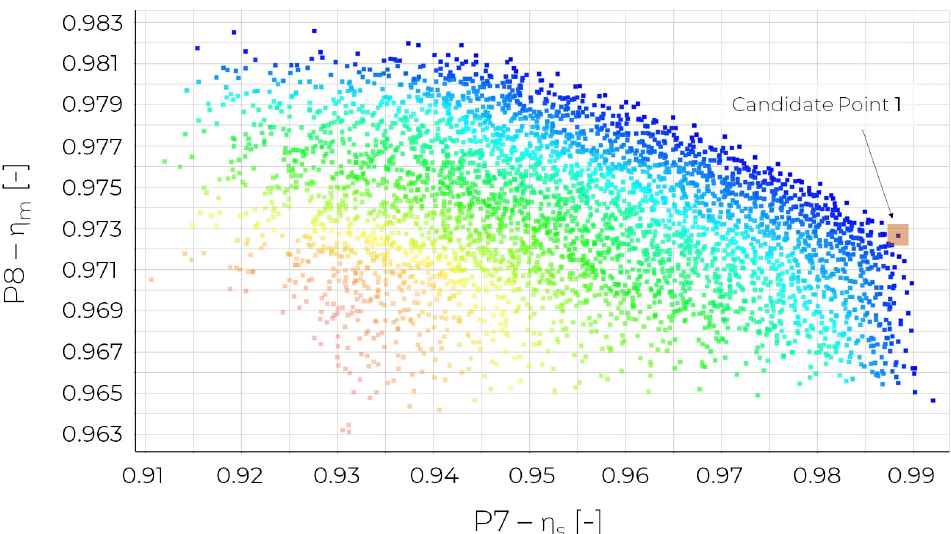
Figure 17. The trade-off chart for design parameters.